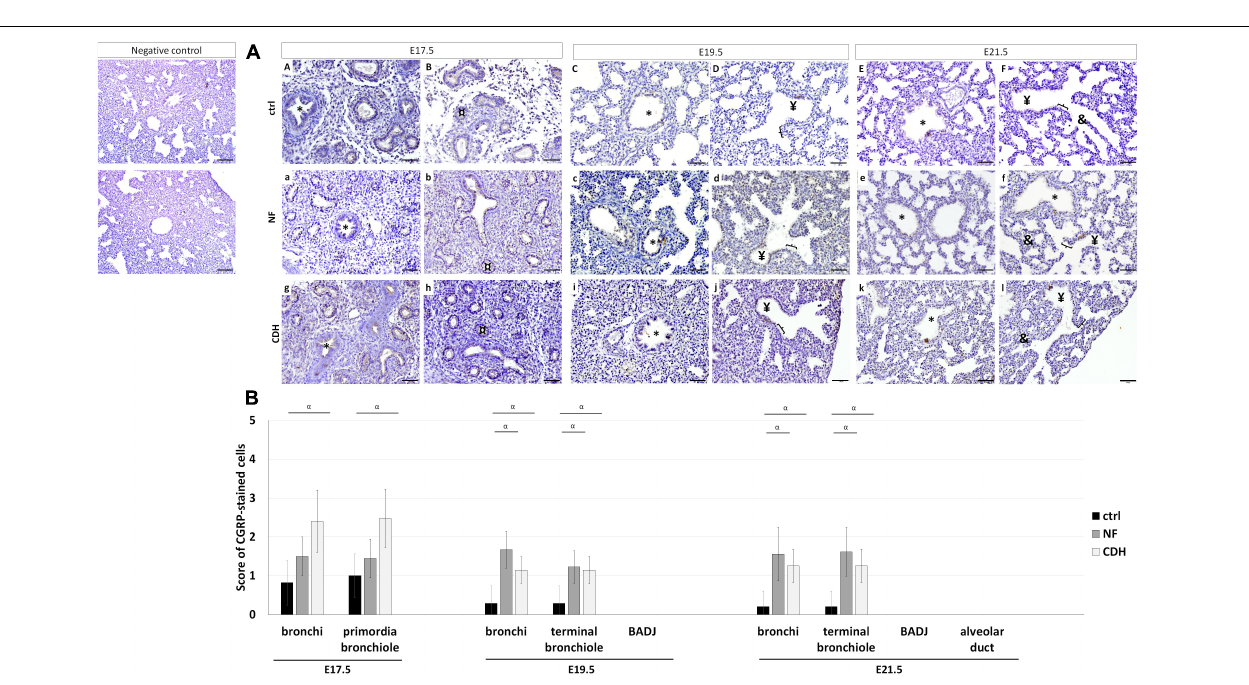
FIGURE 4 | Protein expression pattern of calcitonin gene-related peptide (CGRP) in nitrofen-exposed rat lungs at embryonic day (E) 17.5-to-E21.5. Representative immunohistochemical evidence for CGRP expression at (AA,B,a,b,g,h) pseudoglandular, (AC,D,c,d,i,j) canalicular, and (AE,F,e,f,k,l) saccular stages in normal (ctrl), nitrofen (NF), and congenital diaphragmatic hernia (CDH) rat lungs, respectively. *Bronchiole; ¤ primordia of bronchiole; (cid:85) terminal bronchiole; [bronchioalveolar duct junction; & alveolar duct. Scale bar 50 µ M. (B) Semi-quantitative analysis of CGRP expression from E17.5-to-E21.5 in normal, NF, and CDH lungs. Results are presented as mean µ SD. Symbol indicates main effect and non-redundant interaction of T -test for independent samples. α p < 0.05.